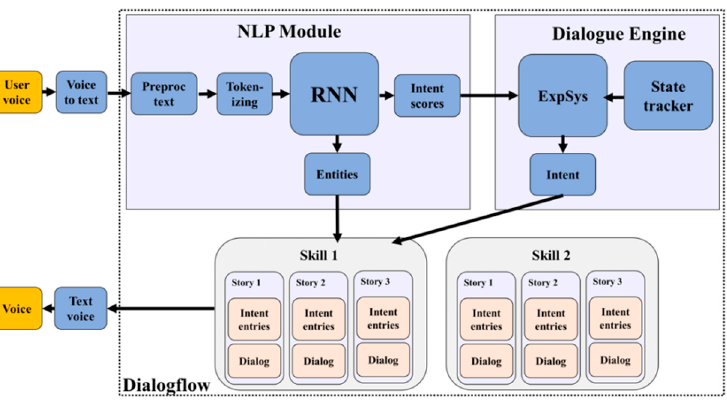
Figure 5. Chatbot engine skill and story design.